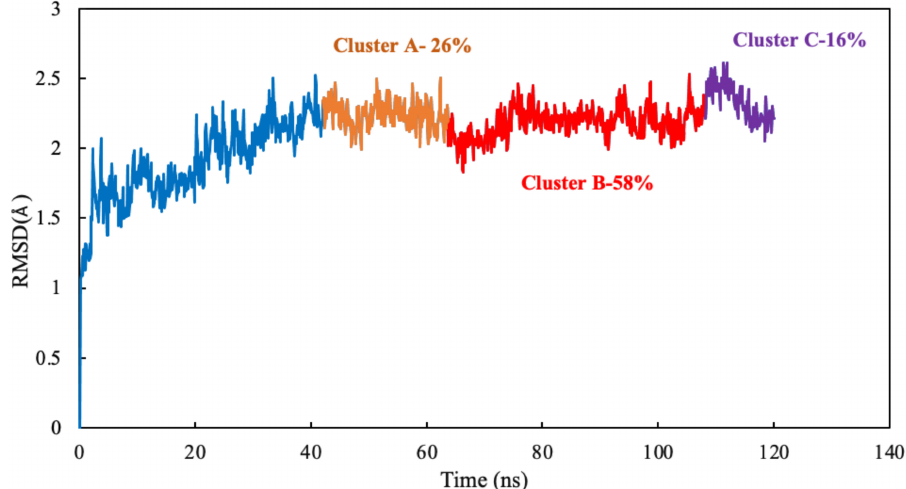
Figure 8. Mass-weighted root–mean–squared deviation (Å) of the binding site of colchicine on tubulin, classified according to the cluster number, with occupancy indicated. The binding site includes scoulerine and residues having atoms within 8 Å of scoulerine. The dark blue part of the graph illustrates the equilibration phase of the